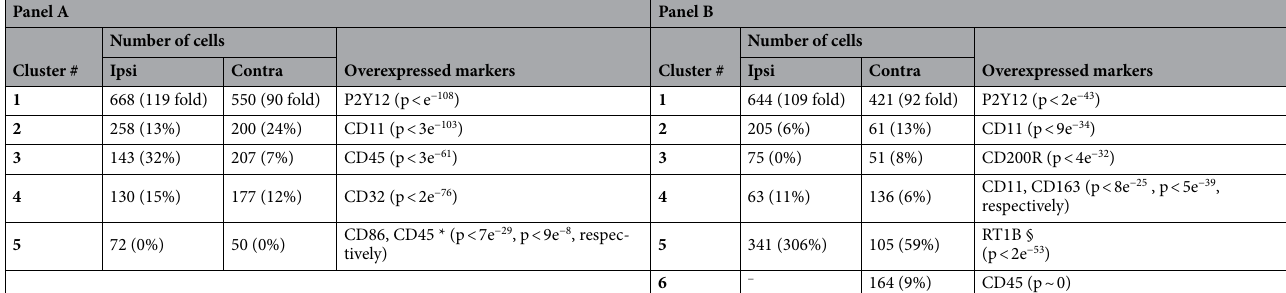
Table 1. Description of identified cell sub-populations with their most prominent markers (mentioning markers with median > 3 standard deviations). Numbers of cells included in sub-populations. Percent of additional cells in the expanded groups in parenthesis. *CD45 less pronounced in contralateral. § RT1B less pronounced in